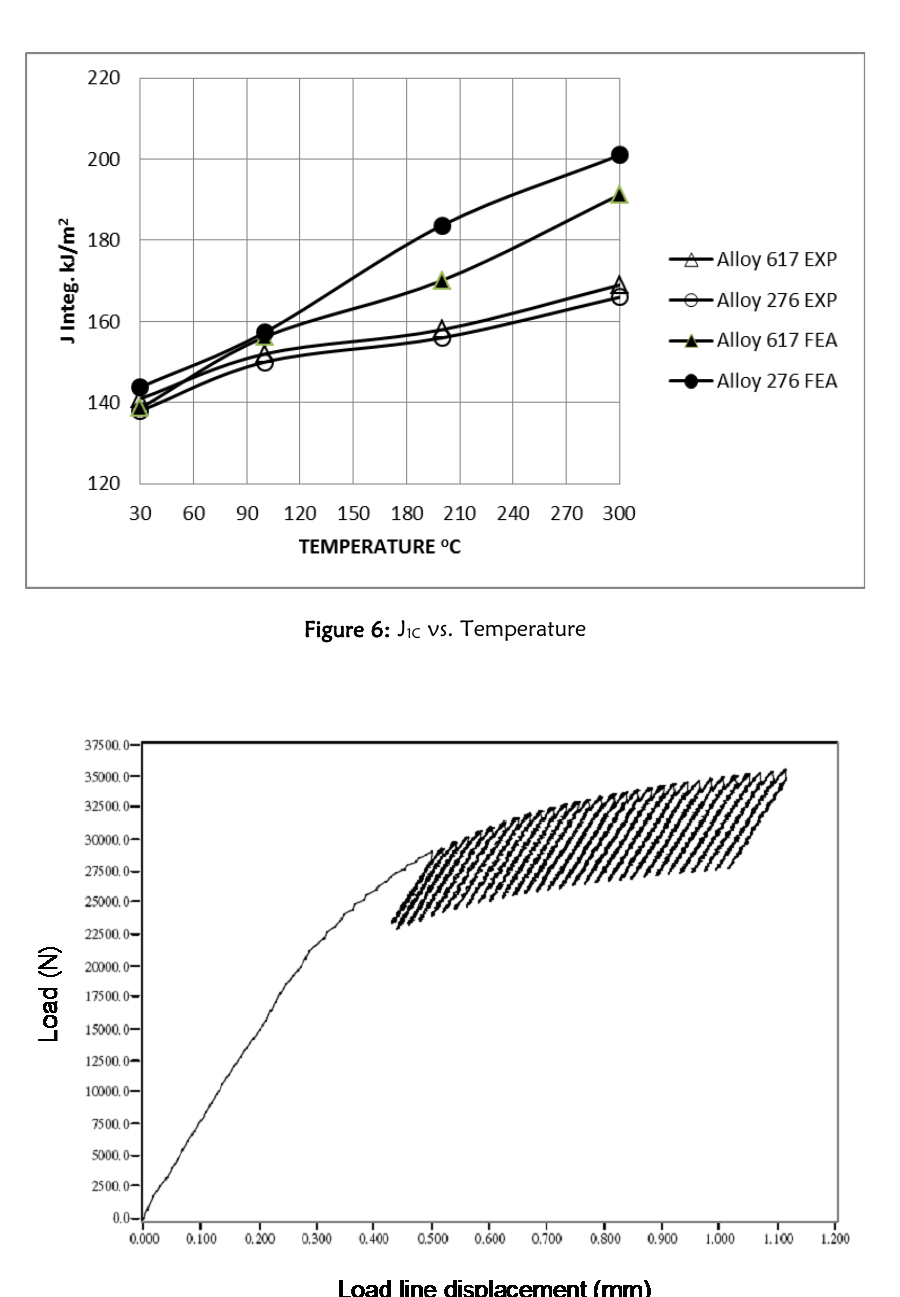
Figure 7: Load vs. LLD at Ambient